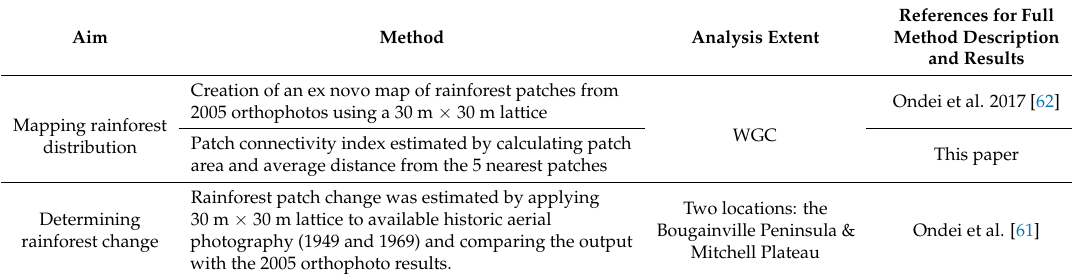
Table 1. Summary of methods presented in this paper. Some approaches were undertaken across all of Wunambal Gaambera country (WGC), while others were limited to comparison of two locations or a single